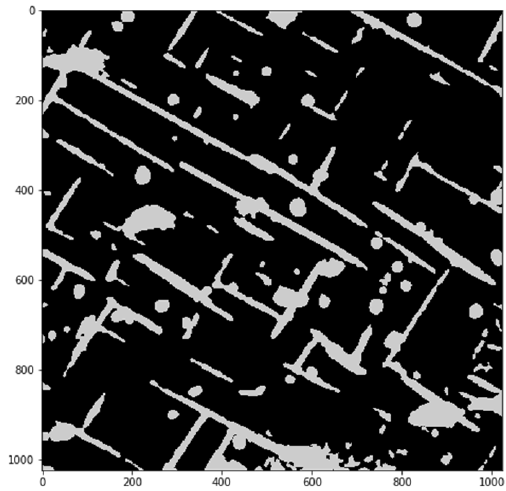
Figure 11. Regions identified as “uncommon”.